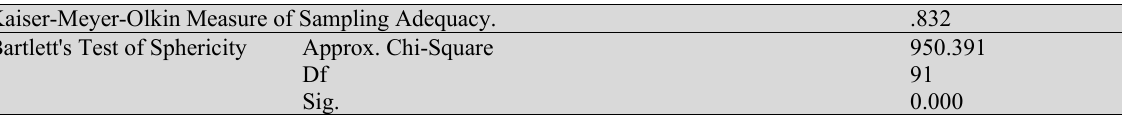
KMO and Bartlett's Test Kaiser-Meyer-Olkin Measure of Sampling Adequacy. .832